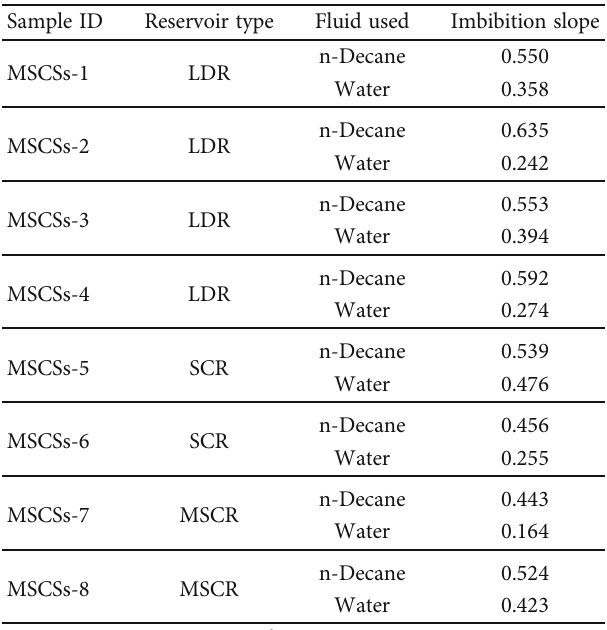
Table 4: Pore connectivity parameters of the eight samples measured by spontaneous